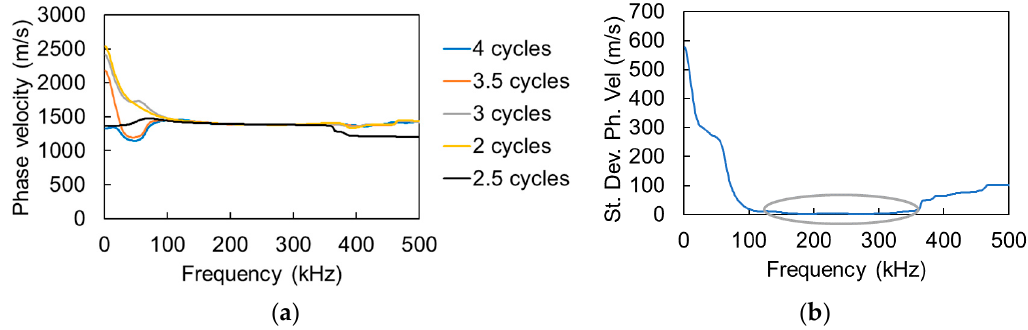
Figure 5. ( a ) Dispersion curves calculated by different parts of the signals and ( b ) standard deviation of the curves of ( a ) for each frequency component.